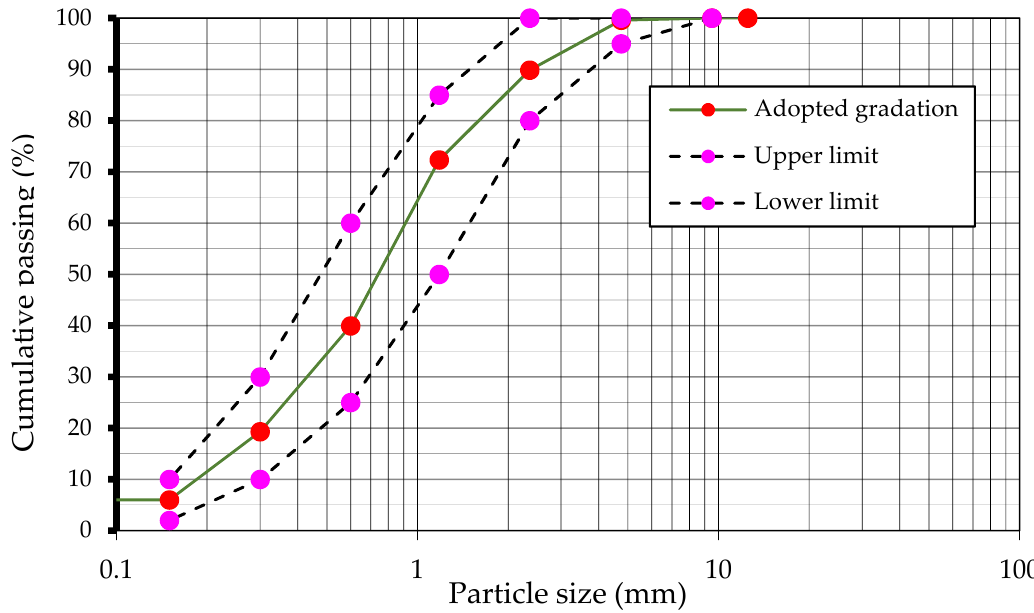
Figure 1. Size distribution curve for aggregate used in the present research.